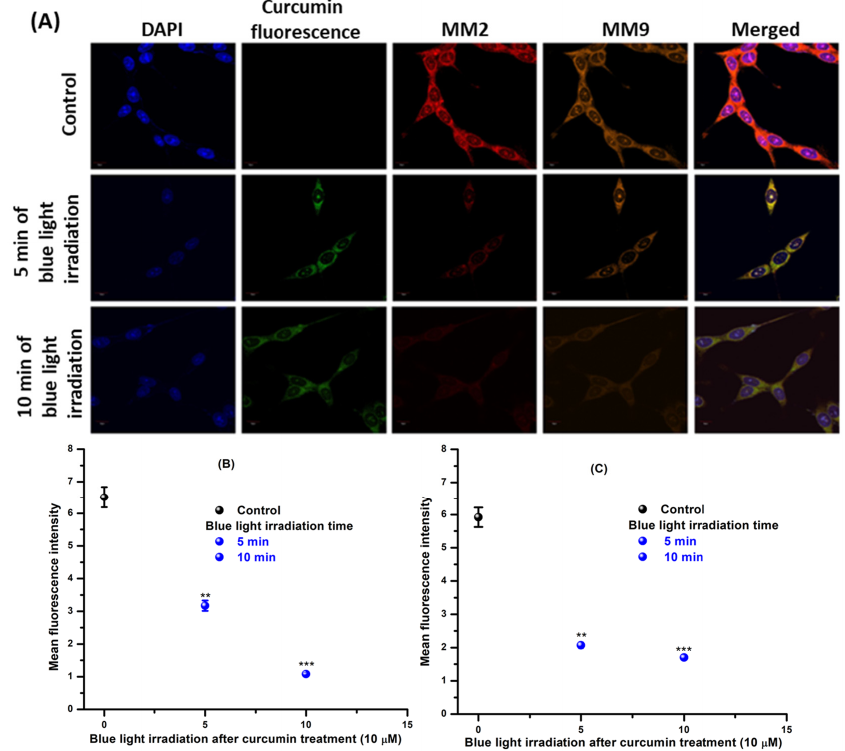
Figure 6. ( A ) Internalization of Curcumin (10 µM) and the expression of MMP2 and MM9 after 5 and 10 min of blue light exposure. ( B ) and ( C ) are the plots showing statistical analyses of MMP2 and MMP9, respectively. The * denoted control versus 5 min of irradiation after Curcumin treatment (10 µM), ** denoted control versus 10 min of irradiation after Curcumin treatment (10 µM) and *** denoted control versus 10 min of irradiation after Curcumin treatment (10 µM). The significant results presented a p value < 0.05.